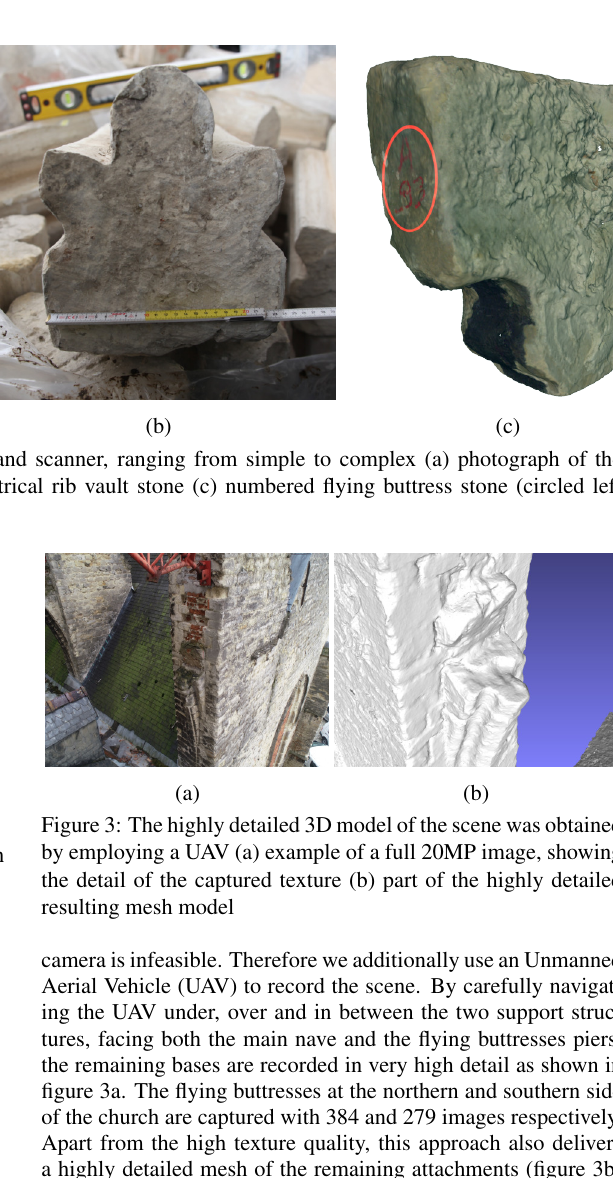
of the church are captured with 384 and 279 images